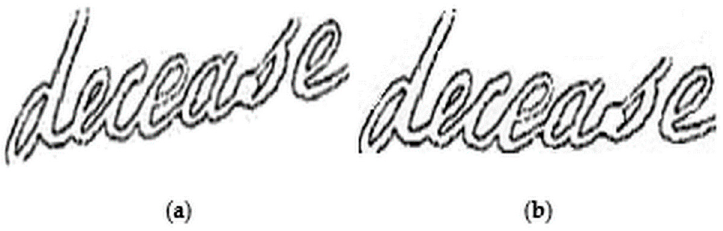
Figure 5. Effect of word normalization on contrast normalized word image. Here, ( a , b ) represent the actual word image and normalized word image, respectively.